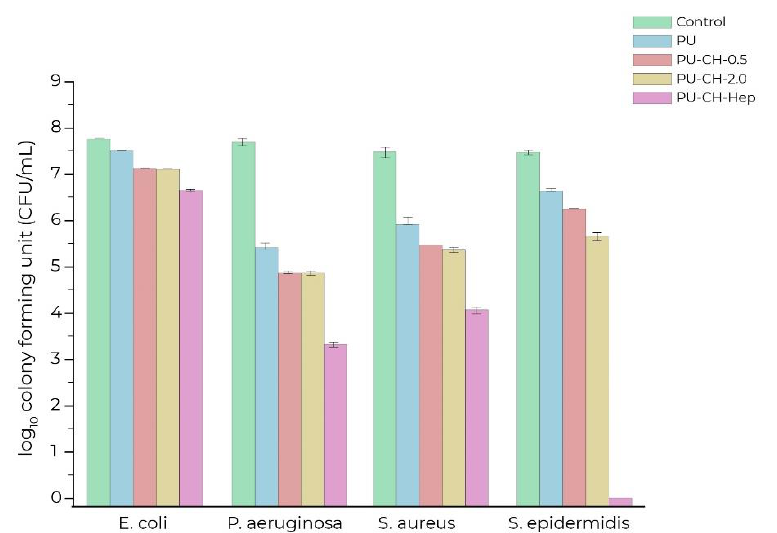
Figure 2. Antibacterial effects on control sample (Control), polyurethanes (PU), chitosan (CH), and heparin (Hep) immobilized on polyurethane films on survival of E. coli, P. aeruginosa, S. aureus and S. epidermidis bacteria. Adapted from Ref. [29].